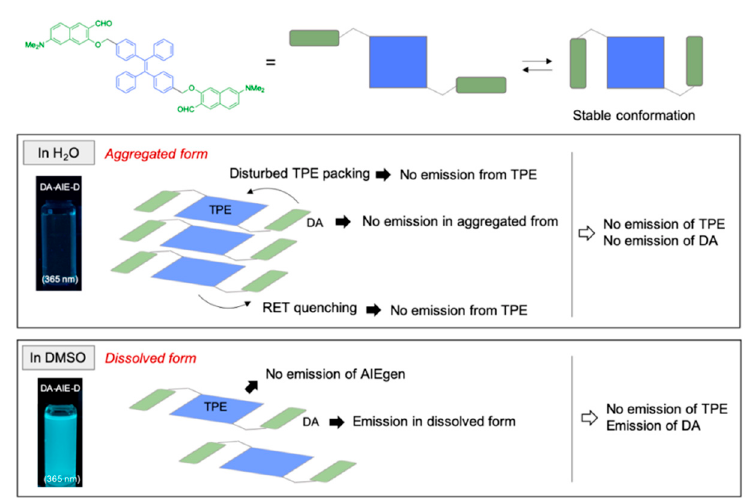
Figure 6. Proposed mechanism for the photophysical properties of DA-AIE-D in the aggregated form (in H 2 O) and dissolved form (in DMSO).